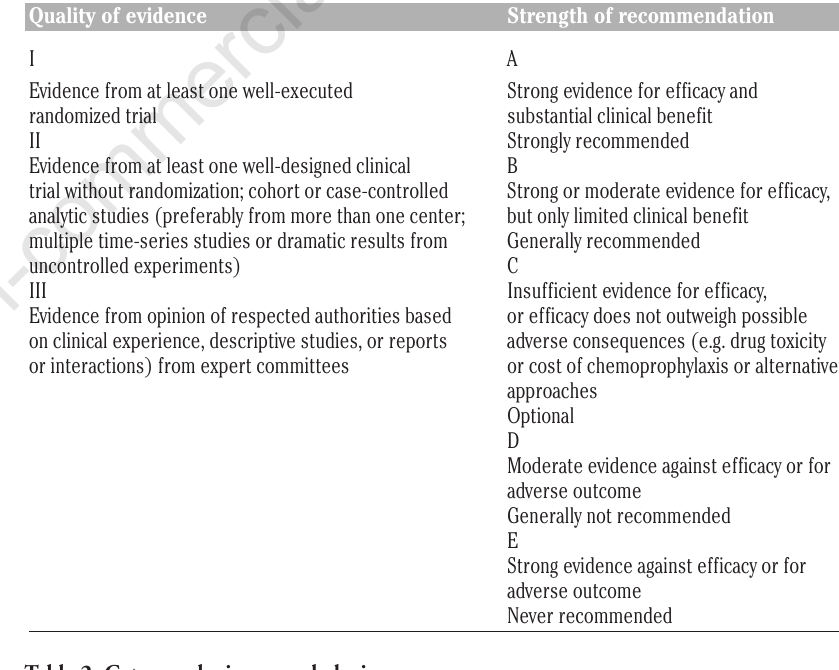
Table 1. Quality of evidence and Strength of recommendations according to the CDC grading system. 23